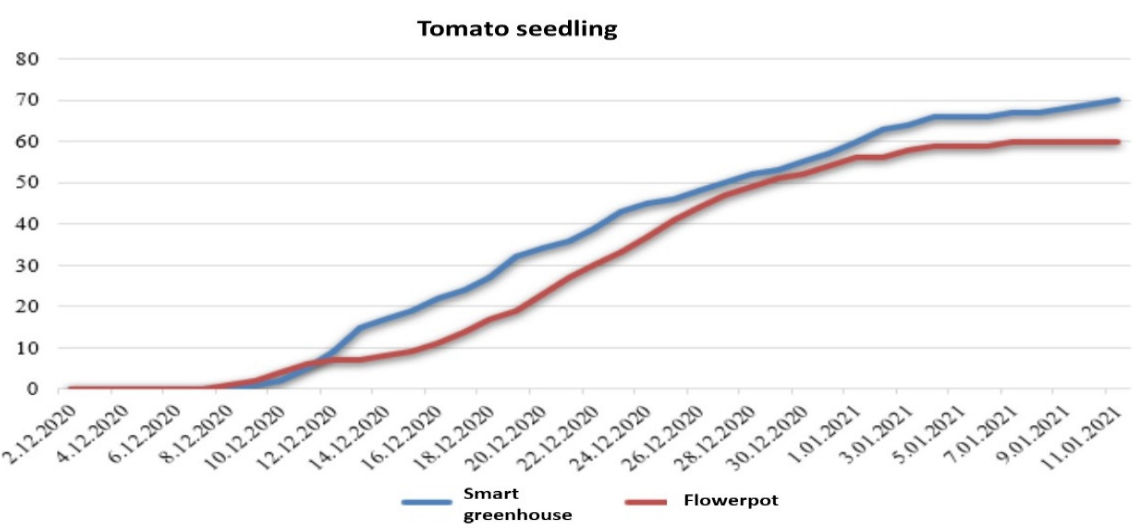
Figure 14. Development graph of cucumber in smart greenhouse and pot.